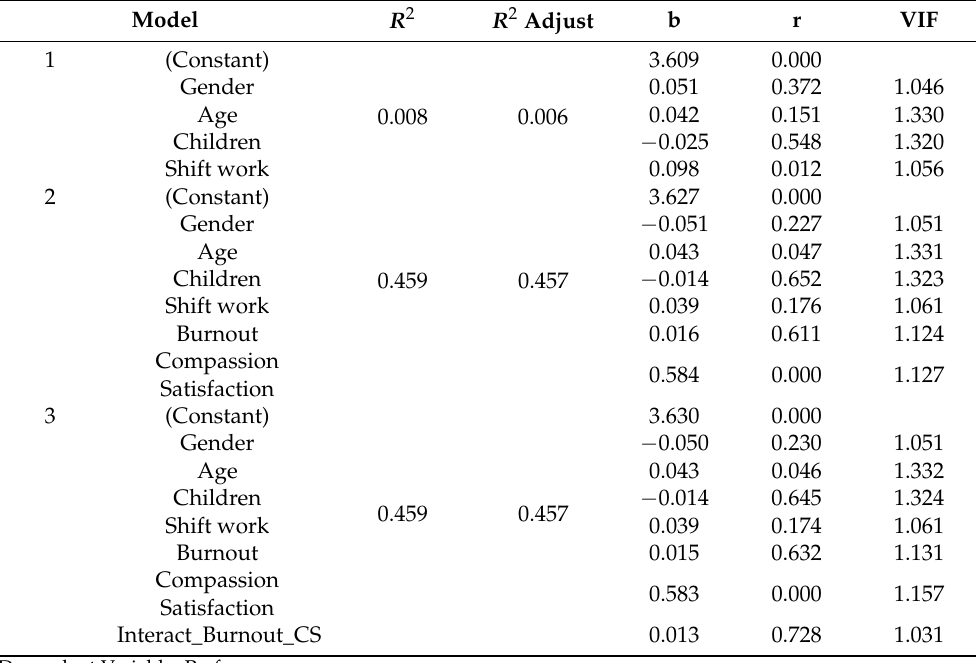
Table 2. Regression between Burnout, Performance and Compassion